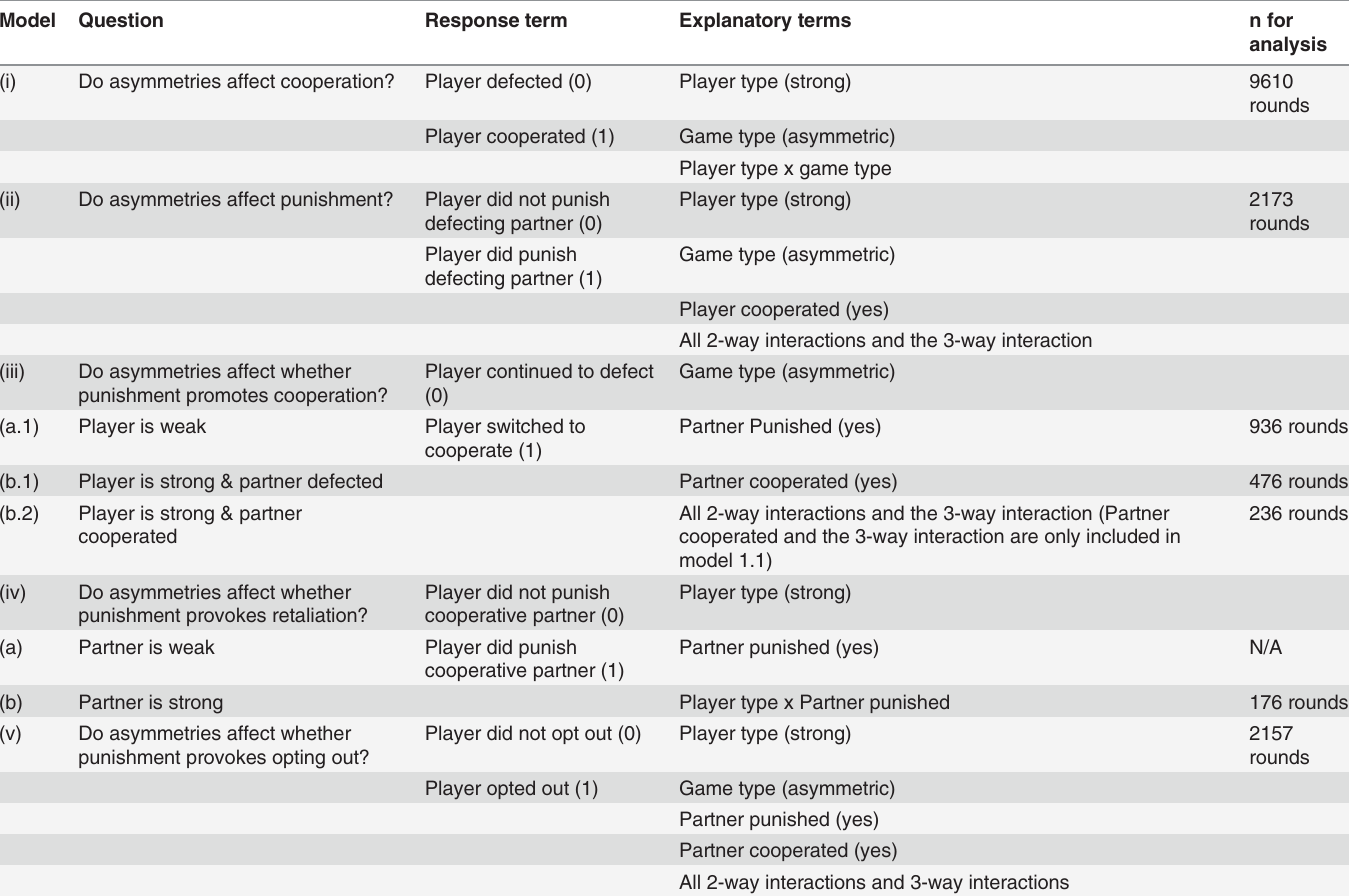
Table 2. Explanatory terms: player type is a 2-level factor with levels 'weak' and 'strong'; game type is a 2-level factor with levels 'symmetric' and 'asymmetric'; player cooperated is a 2-level factor describing whether the player cooperated or defected in the current round; partner punished is a 2-level factor describing whether or not the player was punished by their partner in the previous round; partner cooperated is a 2- level factor describing whether the partner cooperated or not in the previous